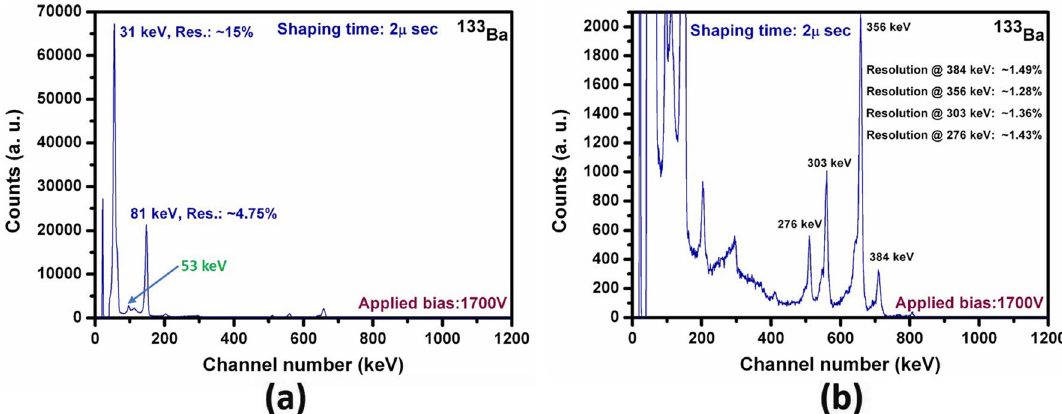
Figure 6. ( a ) Pulse height spectrum of 133 Ba source of the Frisch-grid detector fabricated from as-grown